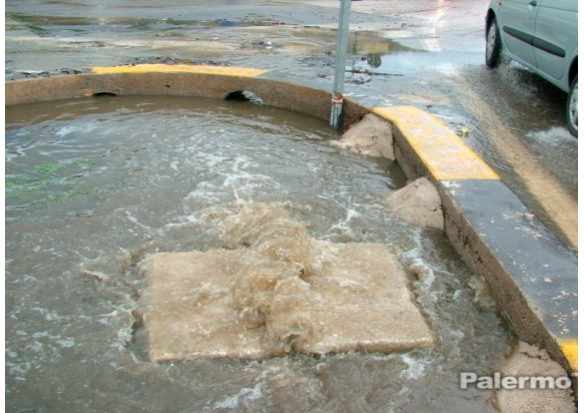
Figure 6. Rainfall depth: events on 11 September, 1 October and 10 October 2021.